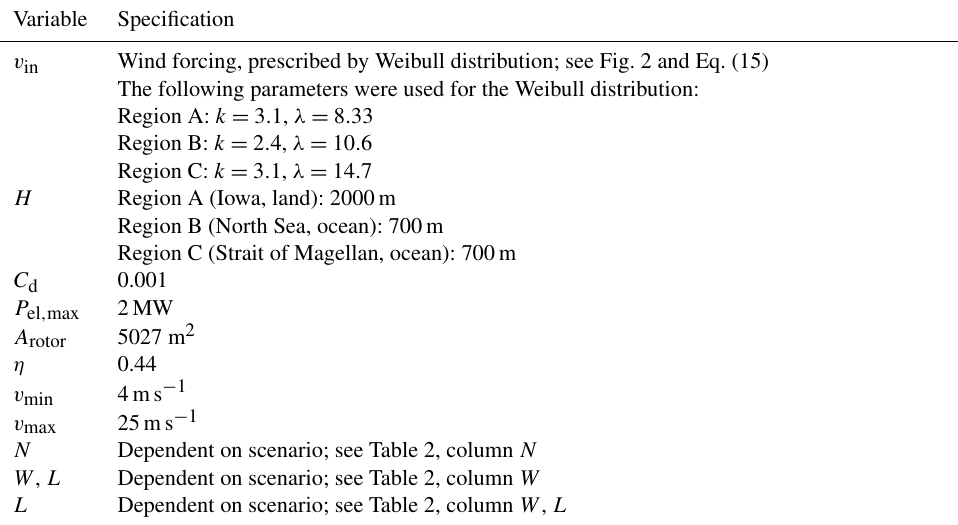
Table 3. KEBA parameters used to evaluate the scenarios of Volker et al.